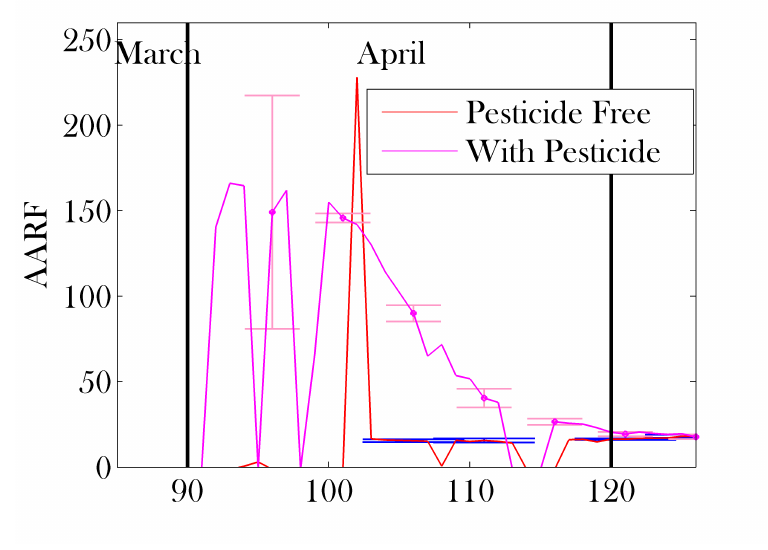
Figure 10. The average age of recruitment to foraging calculated in 7 simulations without pesticides (red line) and a simulation with pesticide treated plants (magenta line) through spring. Error bars, blue and pink respectively, represent one standard deviation. Compared with the results in Figure 9, the value of AARF is here seen to be generally higher and highly volatile in April. This is caused by large swings in the ambient temperature during this time, the ageing of bees and the absence of new bees during winter. Thus AARF is not a useful metric of the health of the colony during early